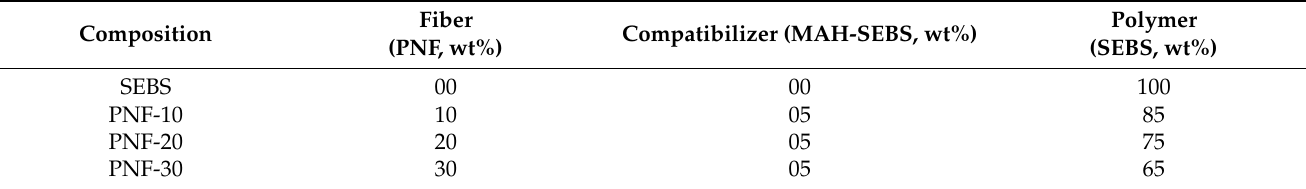
Table 1. Compositions of the PNF/SEBS